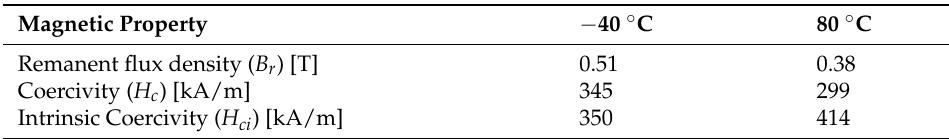
Table 8. Magnetic properties of NMF-12G at −4 0 and 80 °C.